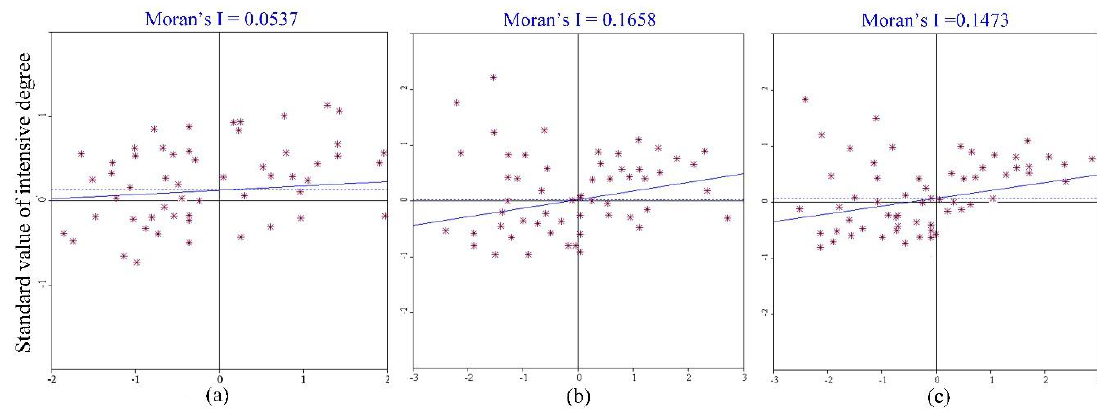
Figure 5. Moran scatter plot chart denoting the heterogeneity of local space. ( a ) Moran scatter plot for residential land cover spatial pattern agglomeration indexes; ( b ) Moran scatter plot for commercial land cover spatial pattern agglomeration indexes; ( c ) Moran scatter plot for industrial land cover spatial pattern agglomeration indexes.